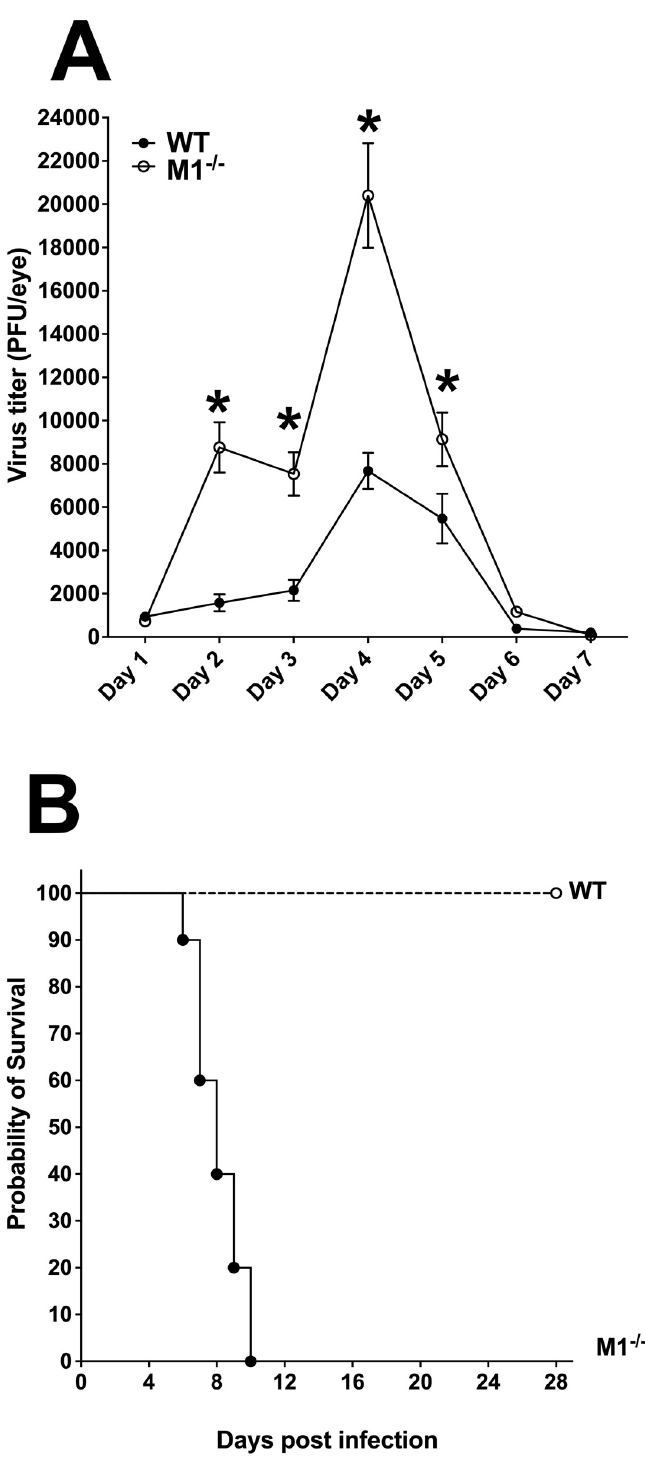
Fig 5. Virus replication and survival of M1 -/- -infected mice. A) Virus replication in tears of infected mice. WT and M1 -/- mice were ocularly infected with 2 X 10 5 pfu/eye of McKrae virus without corneal scarification. Tear films were collected on days 1–7 PI and virus titers were determined by standard plaque assays as described in Materials and methods. Each point represents the mean ± SEM of 20 eyes per group. p-values less than 0.05 were considered statistically significant and marked by a single asterisk ( � ); and B) Absence of M1 macrophages enhanced mortality in